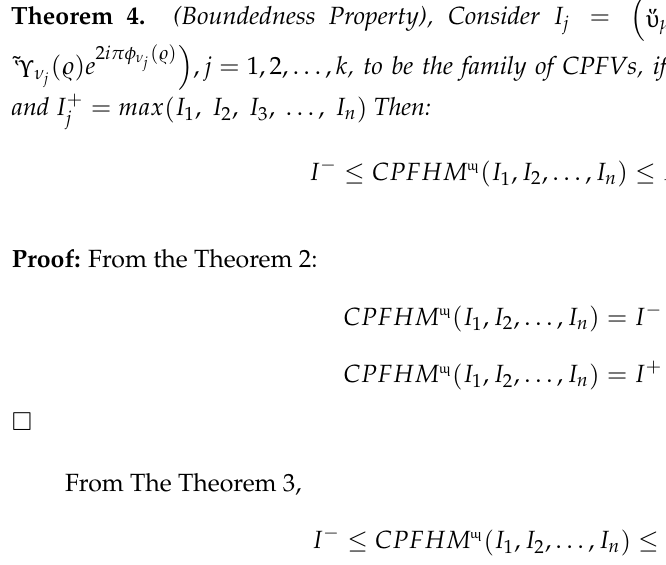
Table 1. Symbols and their meanings.